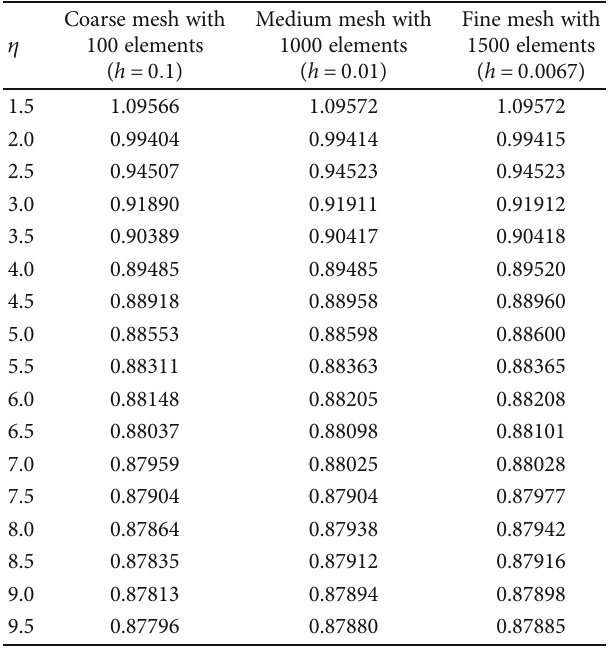
Table 3: Grid-independence test for concentration distributions j ϕ ′ ð η Þj .